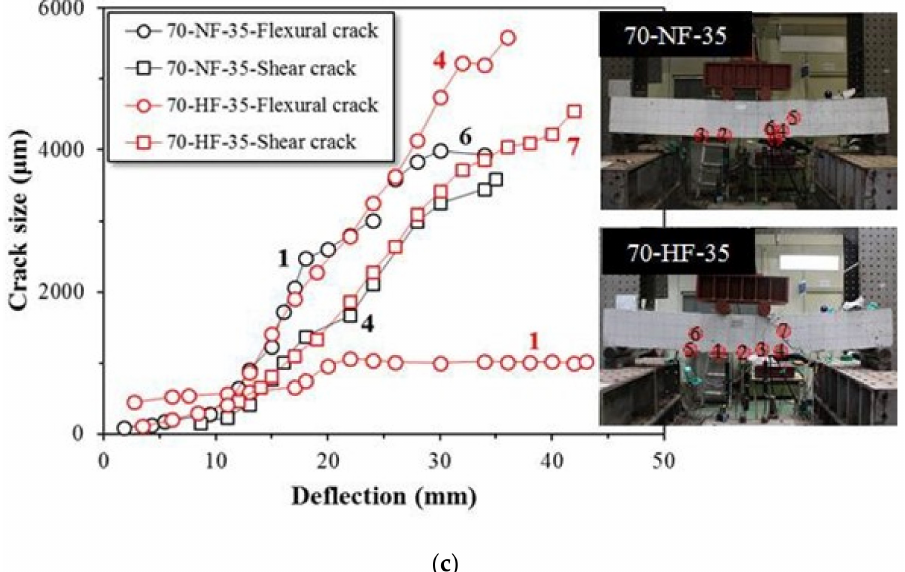
Figure 4. Effects of fiber tensile strength on crack width of steel fiber-reinforced concrete beam specimens at shear span ratios of ( a ) Shear span ratio of 1.5, ( b ) Shear span ratio of 2.5, and ( c ) Shear span ratio of